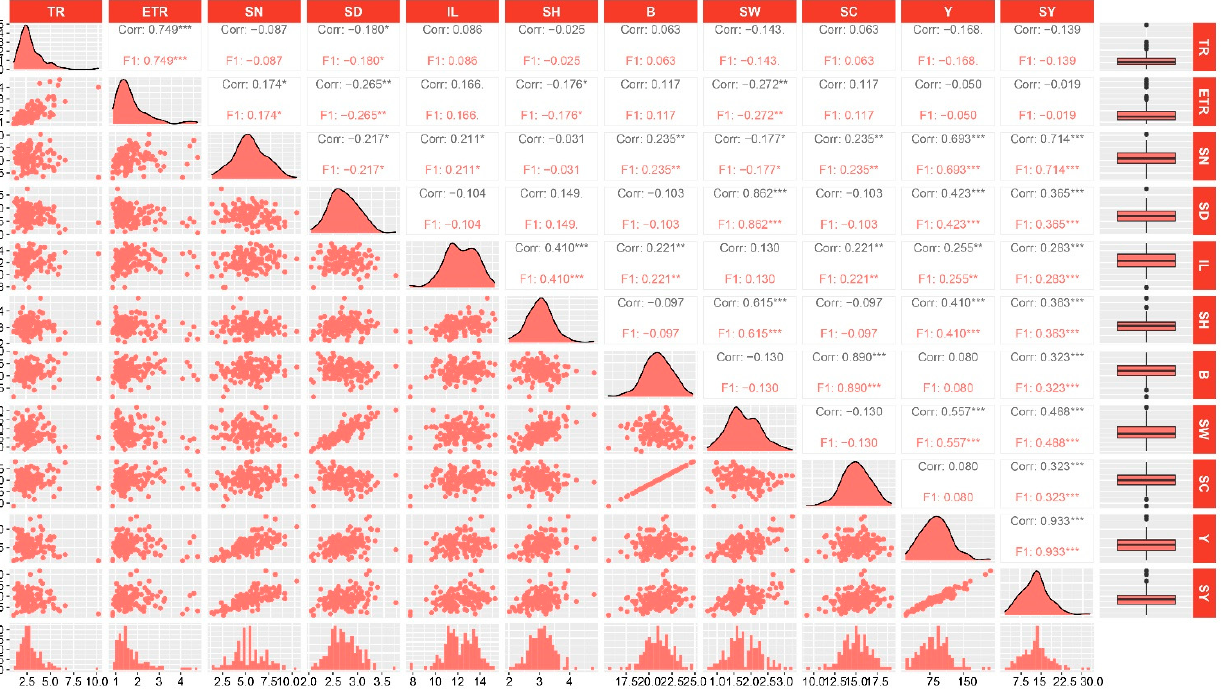
Figure 1. Distribution and correlation analysis of the eleven traits in the hybrid F 1 population. TR, ETR, SN, SD, IL, SH, B, SW, SC, Y, and SY are the abbreviations of tillering ratio, effective tillering ratio, stalk number, stalk diameter, internode length, stalk height, Brix, stalk weight, sucrose content, yield, and sucrose yield, respectively. For each trait, the frequency distribution (bottom), distribution fitting curve (diagonal), boxplot (right), scatter plot (below diagonal), and correlation coefficient between pairs of traits are shown. *, ** and *** represent significant at p < 0.05, p < 0.01, and p < 0.001,